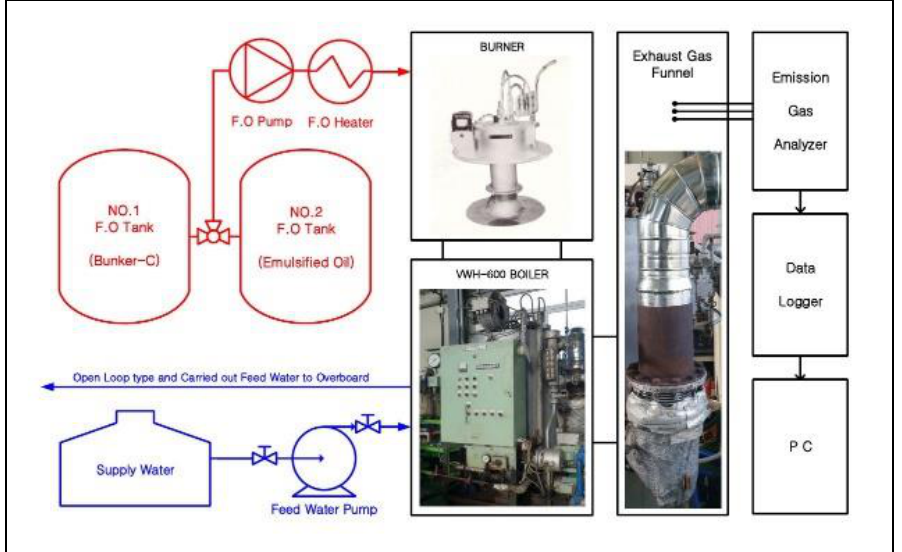
Figure 6. Schematic of experimental apparatus.